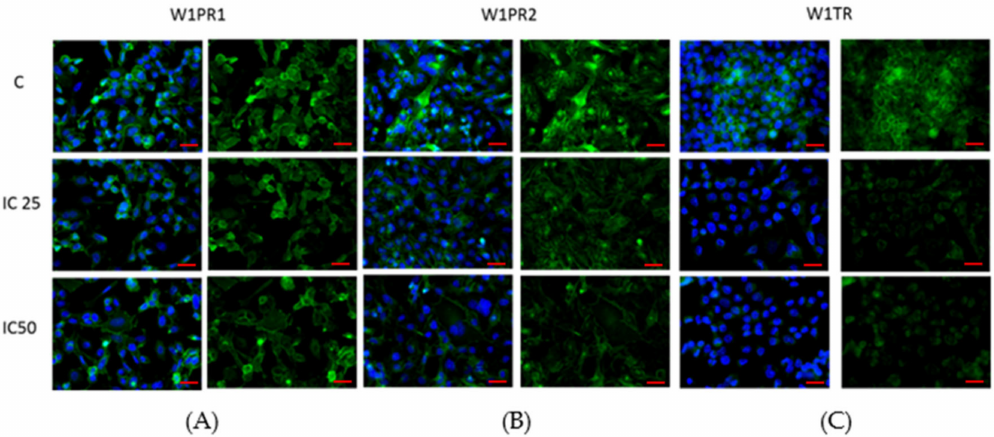
Figure 6. Immunofluorescence visualization of P-gp ( A , B ) and BCRP ( C ) expression in PAC and TOP-resistant cell lines after piperine treatment. P-gp was detected using the anti-P-gp antibody and an Alexa Fluor ® 488-conjugated secondary antibody (green). BCRP was detected using the anti-BCRP antibody and MFP488-conjugated secondary antibody (green). Cell nuclei were stained with DAPI (blue). Row ( C ) shows the control state (cells without piperine), IC25 and IC50 show the cells treated with piperine for 72 h. The first column shows both DAPI (blue) and target protein signal (green), the second column shows the target protein signal alone. Scale bar = 2- µ m.